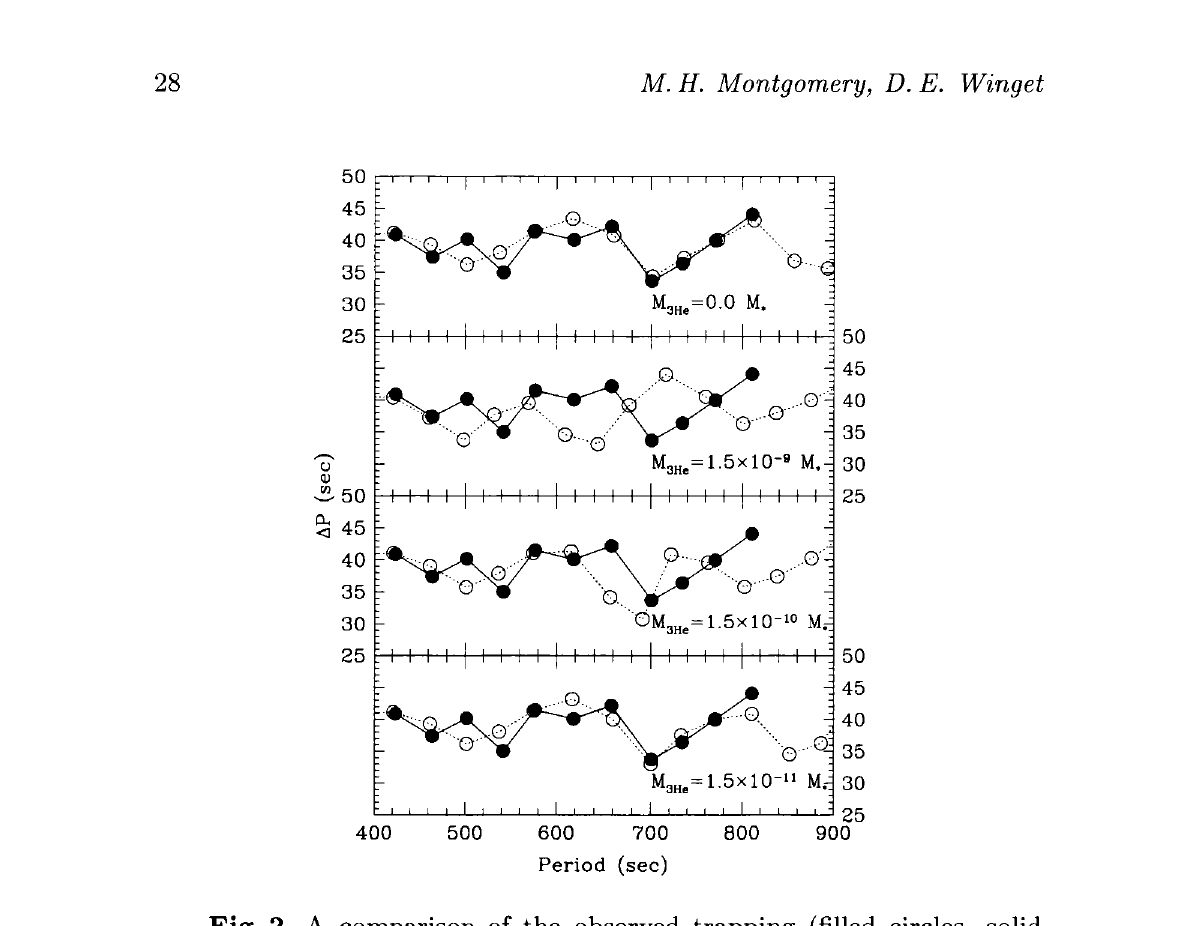
Fig. 2. A comparison of the observed trapping (filled circles, solid lines) with carbon core models (open circles, dotted lines). The top panel is the best-fit model of Bradley & Winget (1994), which is for M^ne = 0.0. The lower panels show the mode trapping structure for nonzero values of M$H e , as indicated in each